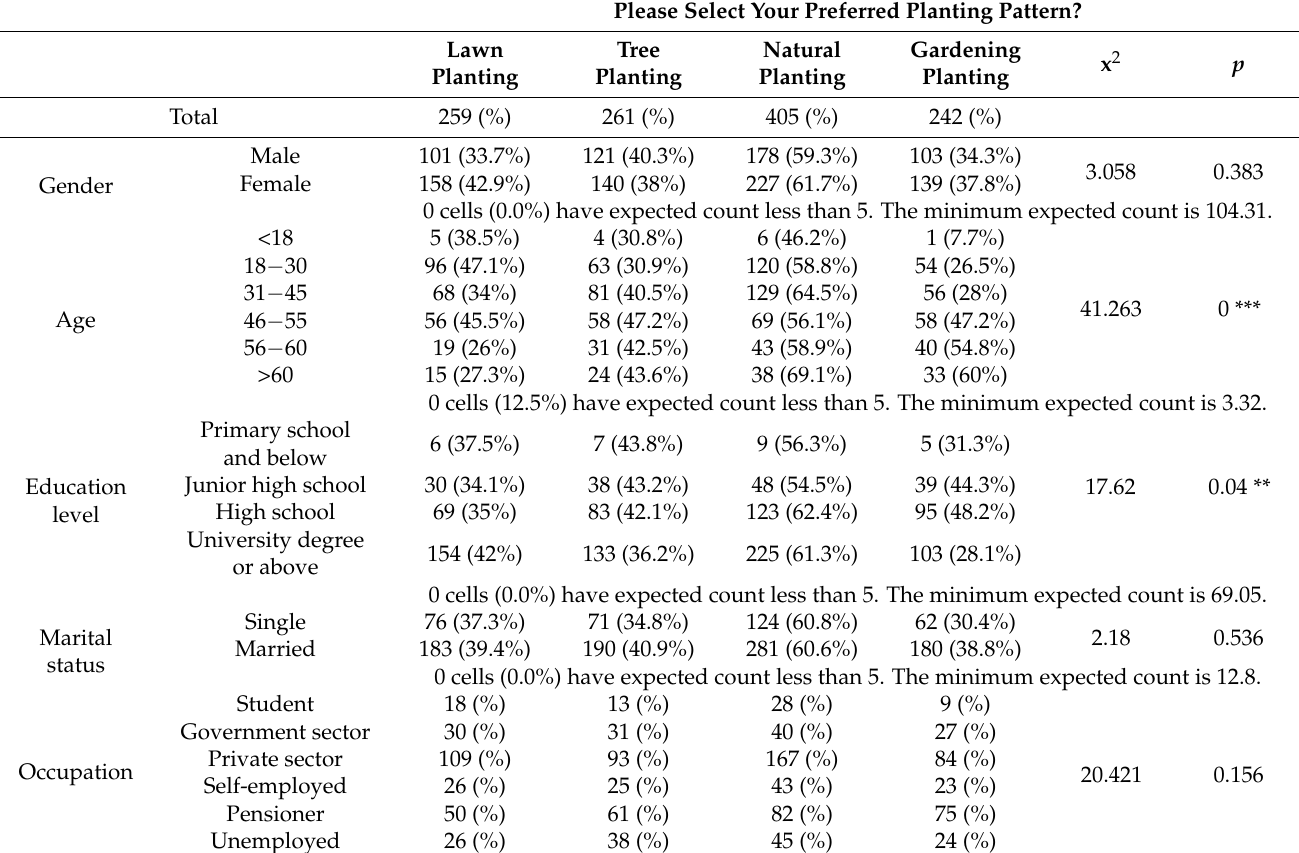
Table A2. The analysis of the soft landscape preferences (chi-square test measure x 2 and p -value). Please Select Your Preferred Planting Pattern? Lawn Tree Natural Gardening x Planting Planting Planting Planting